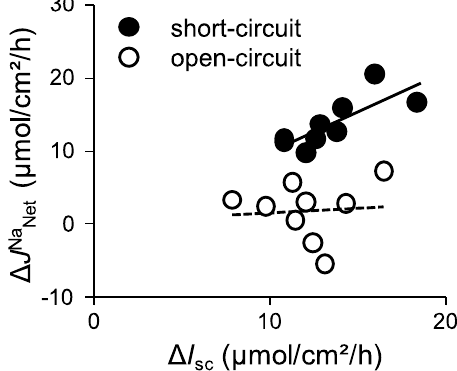
Figure 2. The relationship between changes of glucose-induced I sc (Δ I sc ) and changes of glucose-induced net 22 Na + fluxes (Δ J Na Net ) in wild-type mice: Glucose-induced Δ I sc and net Na + flux ( J NaNet ) were calculated from the data of Figure 1 (short-circuit conditions) and Figure 3 (open-circuit conditions) and replotted. Δ I sc was determined by subtracting baseline values from those obtained after addition of glucose. Mean values for the last two periods after addition of glucose are taken as the change in I sc and J Na . Net Na + flux ( J Na Net ) was calculated using adjacent tissues by subtraction ( J Na MS − J NaSM = J NaNet ). The lines were fitted by least-squares analysis. r 2 = 0.623 and 0.006 for the short-circuit (closed circles) and open-circuit (open circles) conditions, respectively.